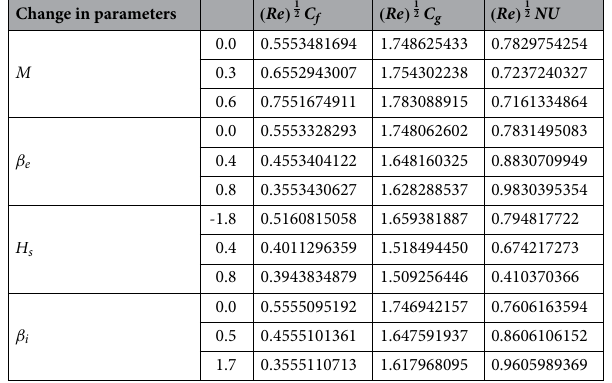
Table 4. Numerical impacts of skin friction coefficients and heat transfer rate versus β e , β i , H s and M when ∅ 1 = 0.002, ∅ 2 = 0.0075, (cid:31) = 2.0, β = 0.01, β = 0.3, Pr = 206, Ec = 2.2. i